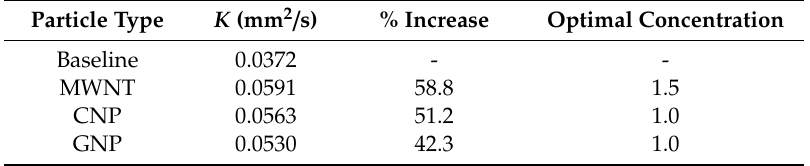
Table 2. Maximum evaporation rate (average) and percent increasing by particle type.